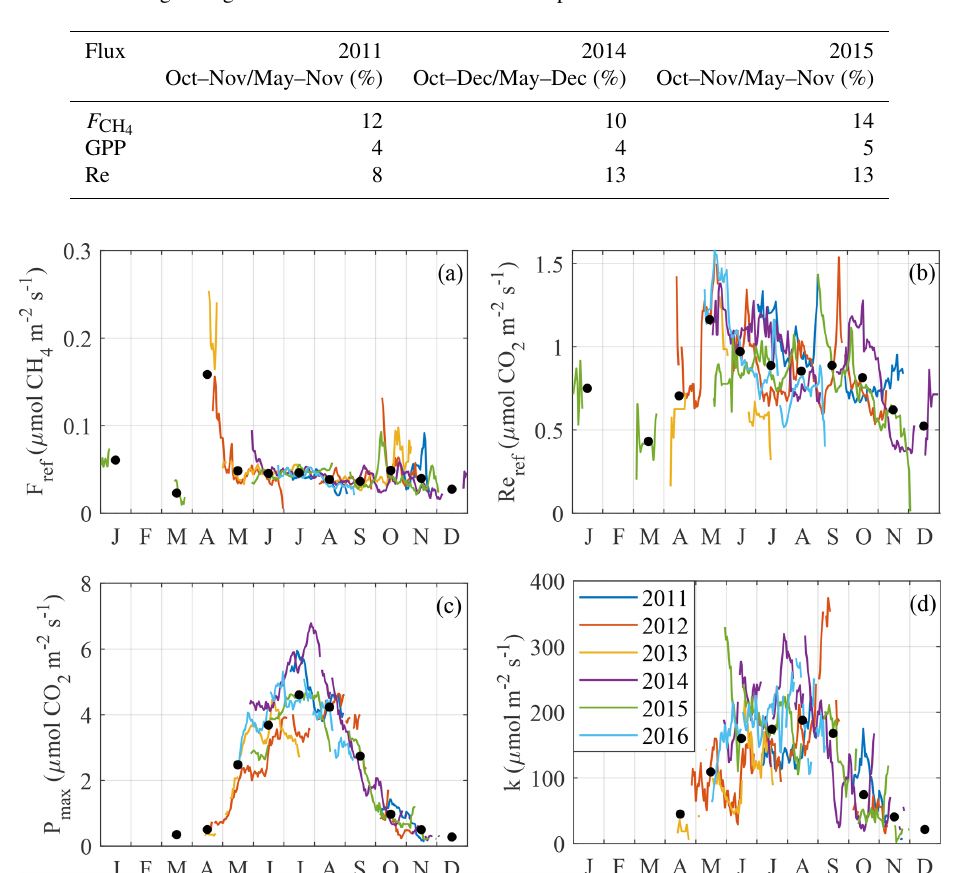
Figure 6. Time series of CO 2 and CH 4 flux model parameters (Eqs. 4–6): (a) Re ref , (b) F ref , (c) P max and (d) k . Monthly averages across years are shown with black dots.